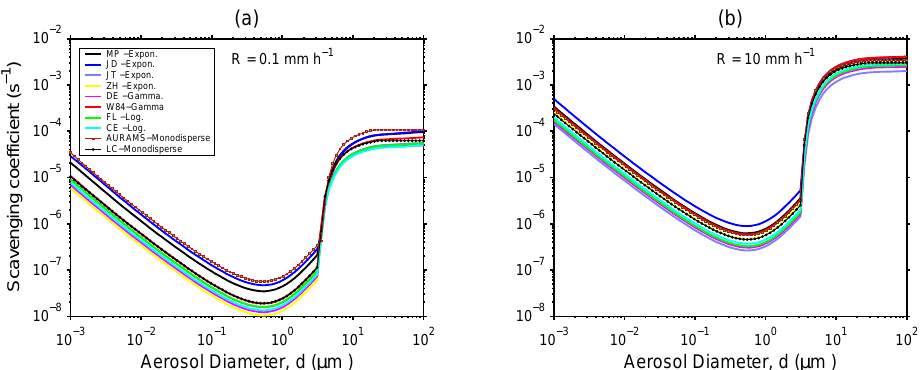
Fig. 5. Scavenging coefficients as a function of particle size derived from 10 different raindrop number size distributions for rainfall intensities of (a) R =0.1mmh − 1 and (b) R =10mmh − 1 : MP – Marshall and Palmer (1948); JD – Joss et al. (1968) drizzle conditions; JT – Joss et